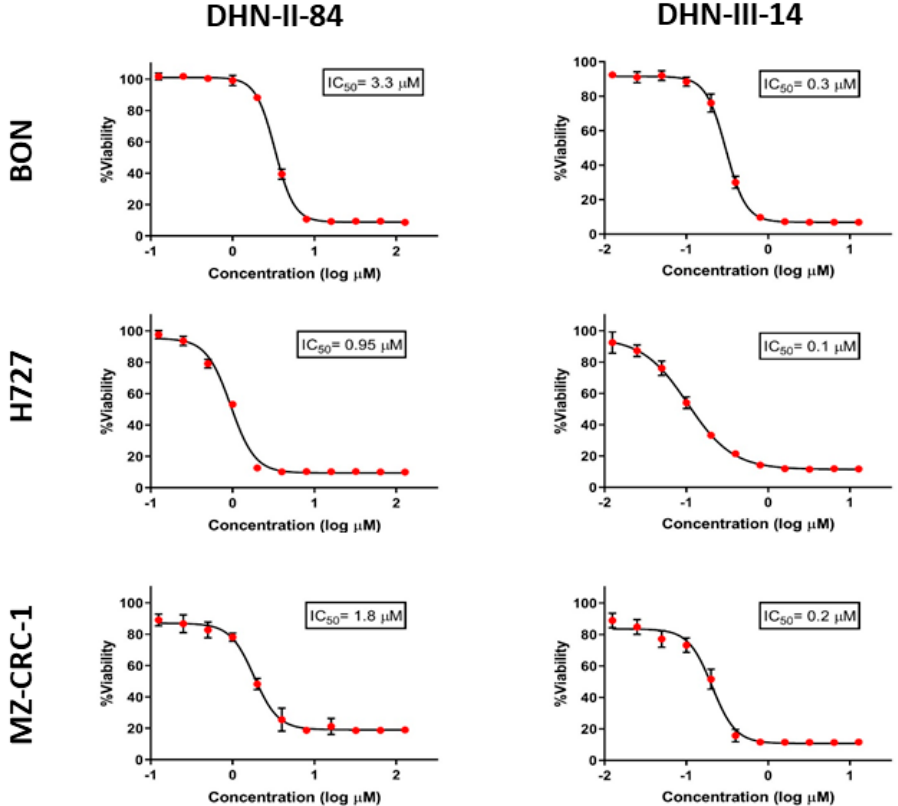
Figure 4. The IC 50 values for DHN-II-84 and DHN-III-14 determined by CellTiter-Glo cell cytotoxicity assay against neuroendocrine cell lines H727, MZ-CRC-1 and BON. Experiments were performed in quadruplicates and data are plotted as mean ± SEM.